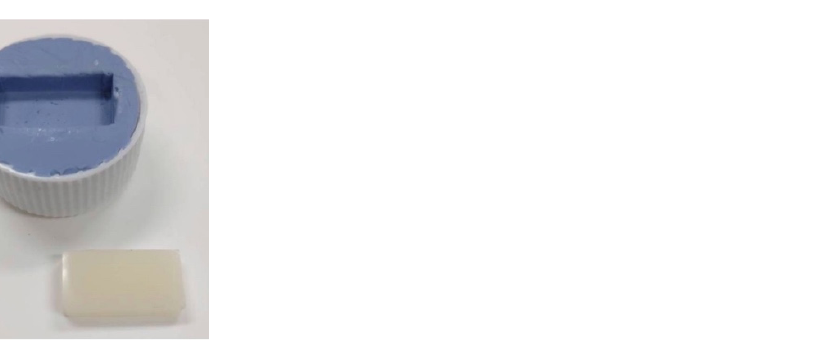
Figure 1. Experimental procedures.